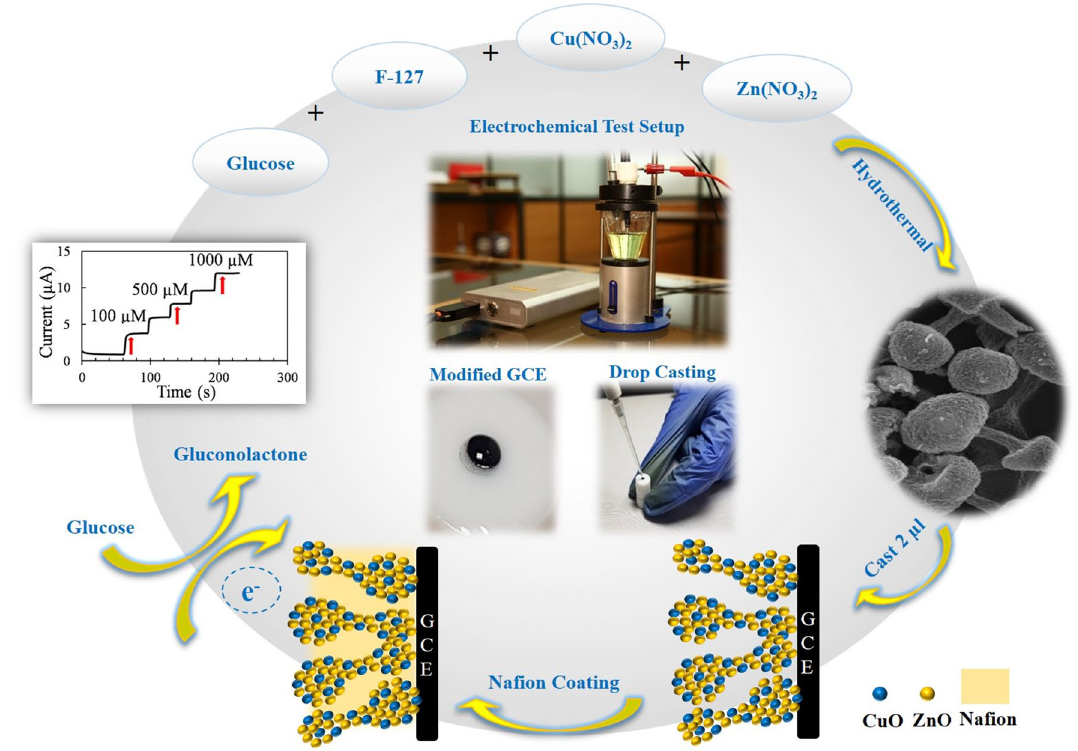
Figure 1. Schematic illustration of the construction and application of CuO/ZnO-DSDSHNM non-enzymatic biosensor for the determination of glucose in human blood synthesized CuO/ZnO-DSDSHNM is shown in Fig. 2a,b. As the main morphology of the material particles, the dumbbell shape structures are clearly observed. In many cases, the size of the heads at each side of the dumbbell is not equal (asymmetrical dumbbell). The hollow nature of the synthesized structure is signified at the inset in Fig. 2a. The hollow nature of these particles could be directly related to the presence of carbon microspheres as a hard template. During the hydrothermal process, the carbon microspheres (Formed in situ from glucose precur- sor) served as the template for the fabrication of the final hollow multi-shelled nanostructure. The removal of the template during the calcination step under the air atmosphere is responsible for the formation of a hollow multi-shelled nanostructure by the strategy of “hard template synthesis”. Using the oxygen-containing air as the calcination atmosphere causes the conversion of the template to CO and facilitates the removal of the carbon template. According to the SEM micrograph at the inset of Fig. 2b, the nanostructured details of each particle could be observed. In addition, the integration of nanoparticles to form the final micron-sized particles has rendered the nanoporous nature of the synthesized particles which is also clear in the SEM micrograph. The formation of the nanoporous surfaces could be attributed to the presence of pluronic F-127 as a surfactant in the synthesis procedure. The holes over some particles are remarked by arrows in Fig. 2a which implies the hollow nature of these particles. Further observation utilizing transmission electron microscopy (TEM) confirmed the results obtained from the analysis of the SEM images. The TEM images indicate the double-shelled structures of CuO/ZnO. As can be seen in Fig. 2c,d, the dumbbell-shaped CuO/ZnO structures are composed of two layers. The inner shell diameter is 170.74 nm and the outer shelled diameter is 393.63 nm (Fig. 2d). Figure 3a,b repre- sent the SEM images of separate CuO and ZnO microspheres (CuO-MS and ZnO-MS), respectively. Accord- ing to the SEM micrograph of the CuO microstructures, the formation of bean-like particles with an average